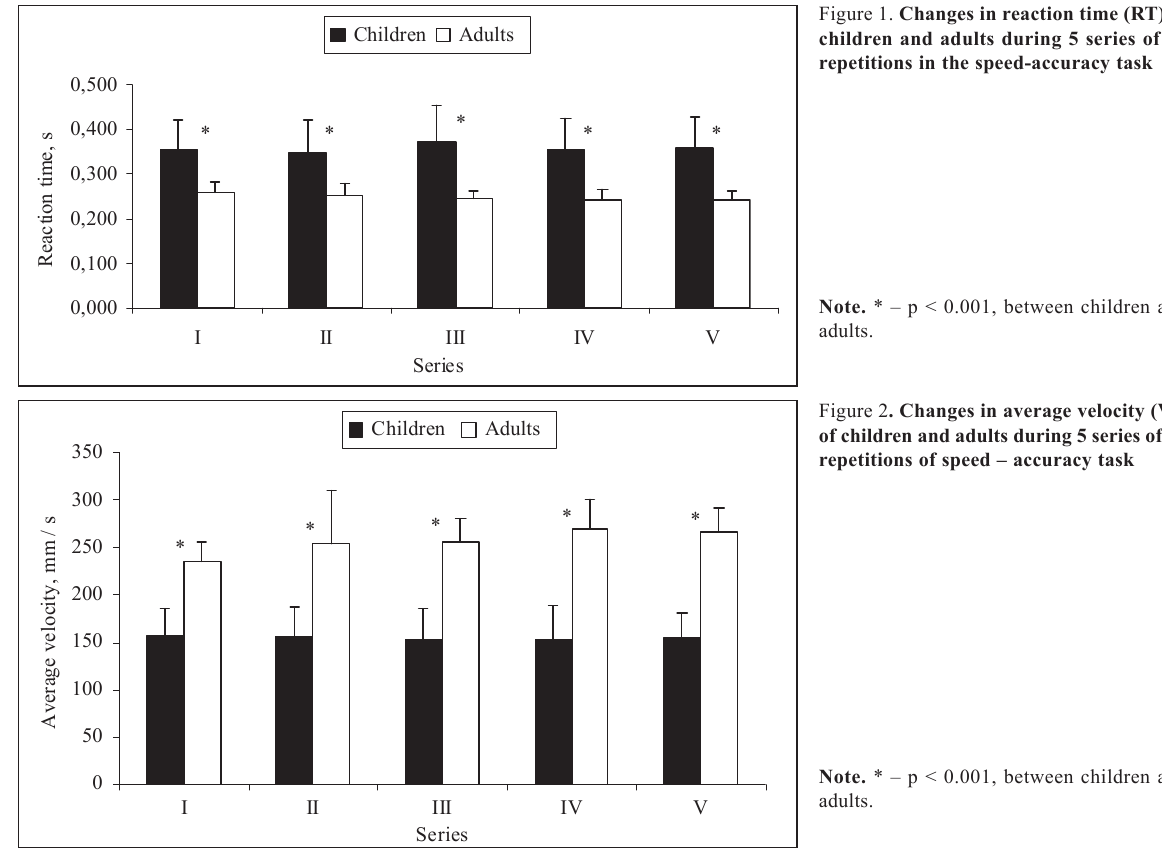
Note. * – p < 0.001, between children and